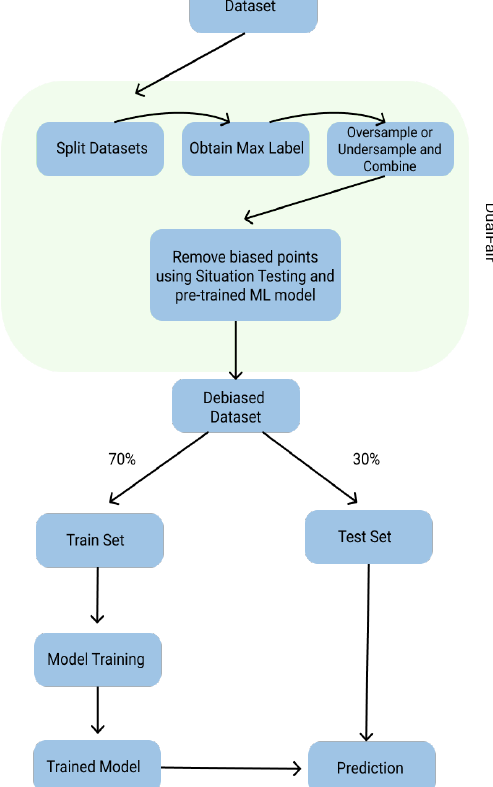
Figure 2. DualFair bias mitigation